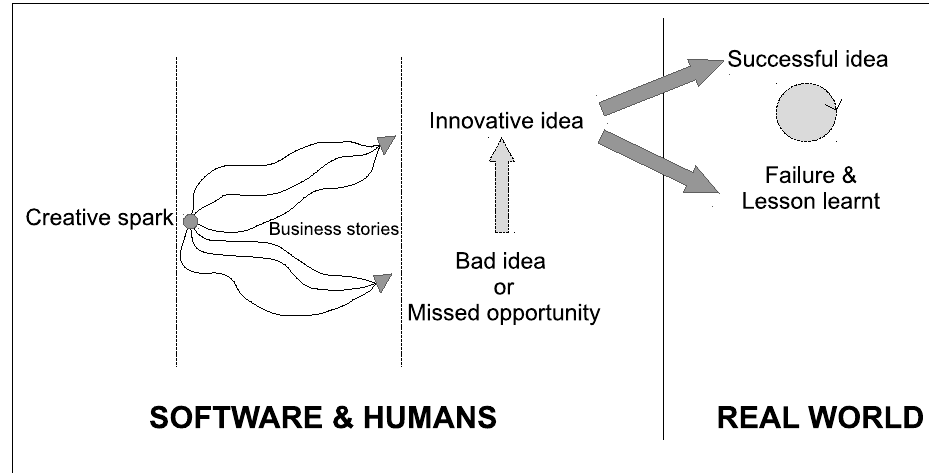
Figure 2. Lifecycle of an idea: from the creative spark(s) to a successful idea for